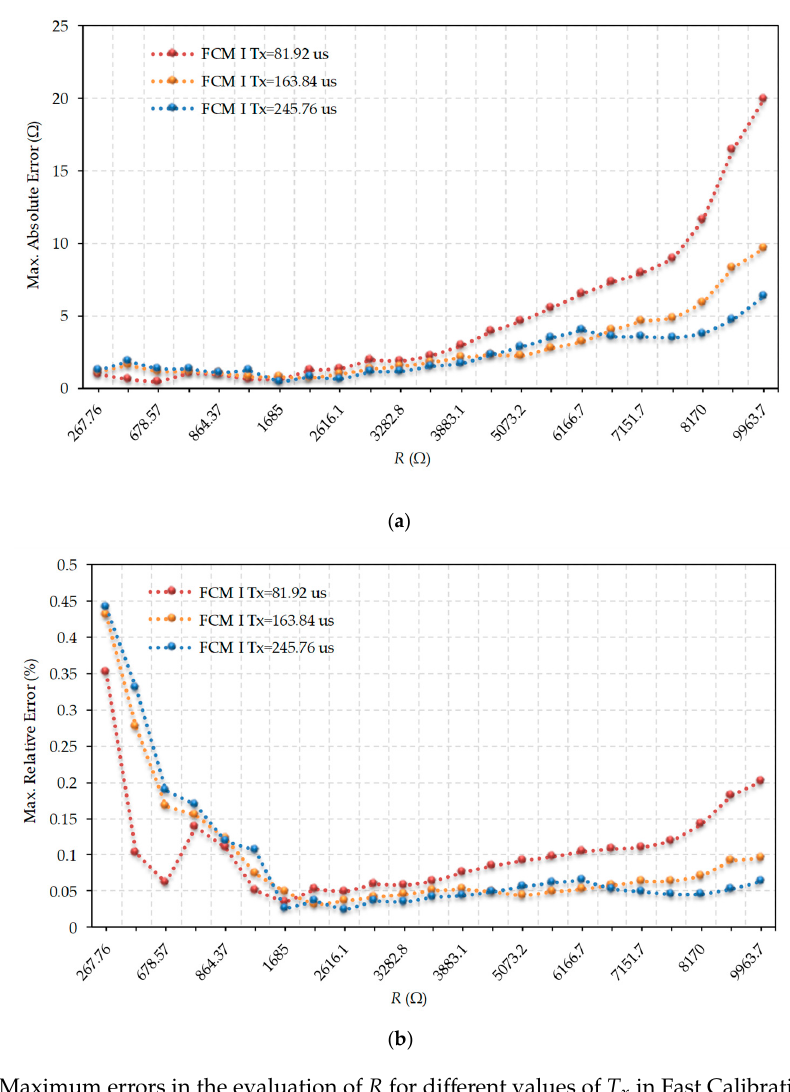
Figure 6. Maximum errors in the evaluation of R for different values of T x in Fast Calibration Method (FCM I). ( a ) Maximum absolute error, ( b ) Maximum relative error.